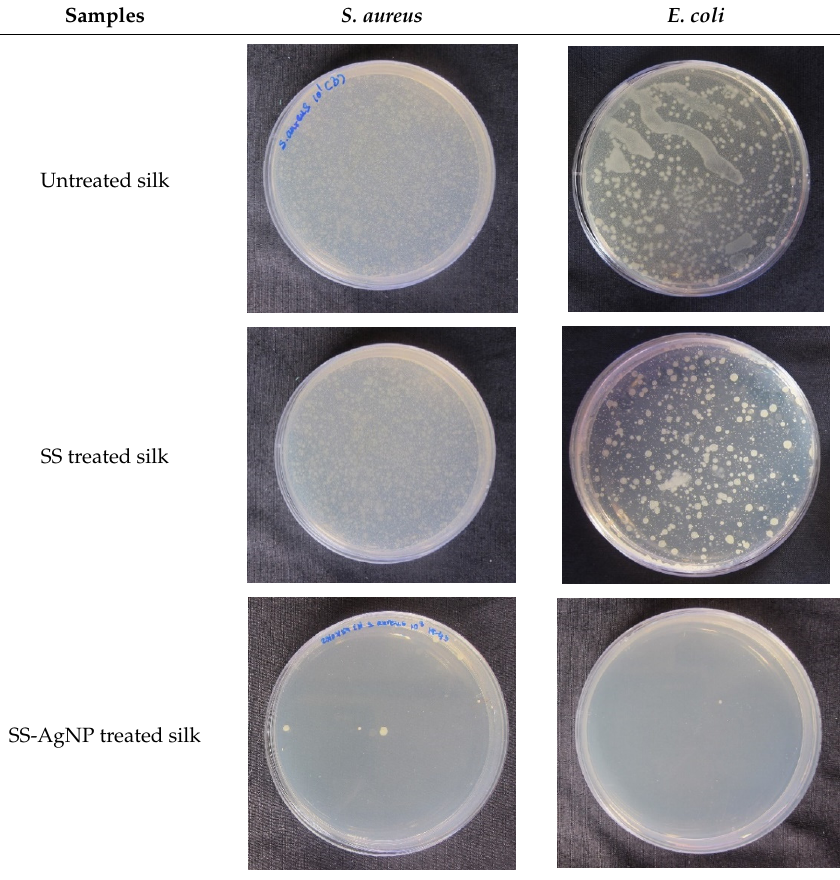
Figure 8. Ag + release profile of SS ‐ AgNP and AgNP finished silks. Table 6. Images of antibacterial activities against two bacterial types.